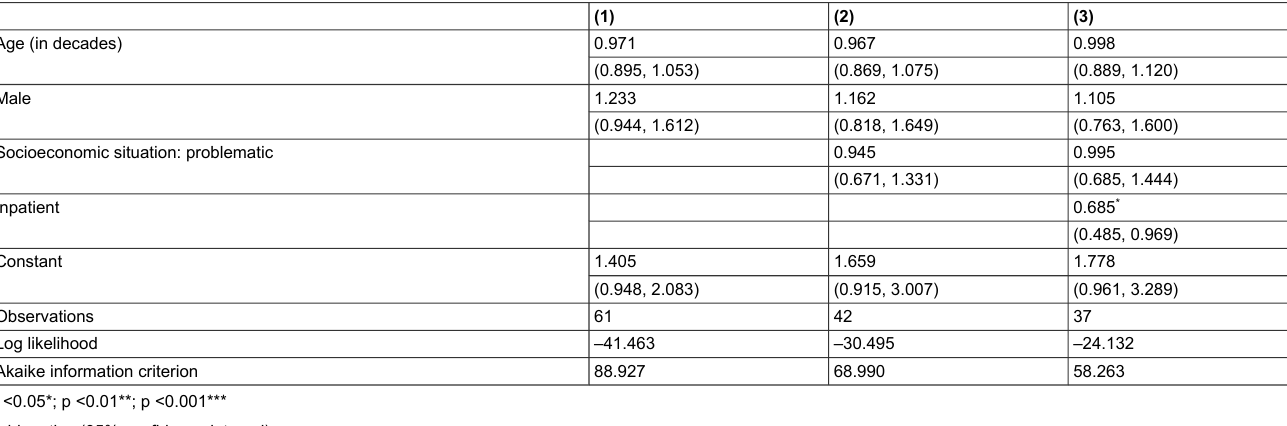
Table 8: Logistic regressions on the response: “Recent significant event = Change/transition of treating